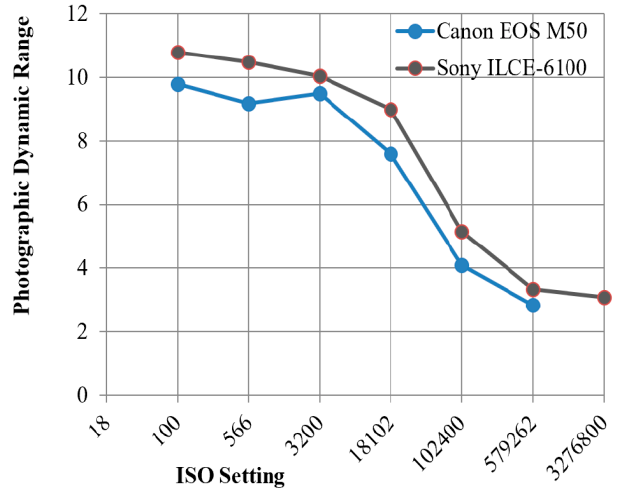
Figure 16. ISO vs. dynamic range comparison.